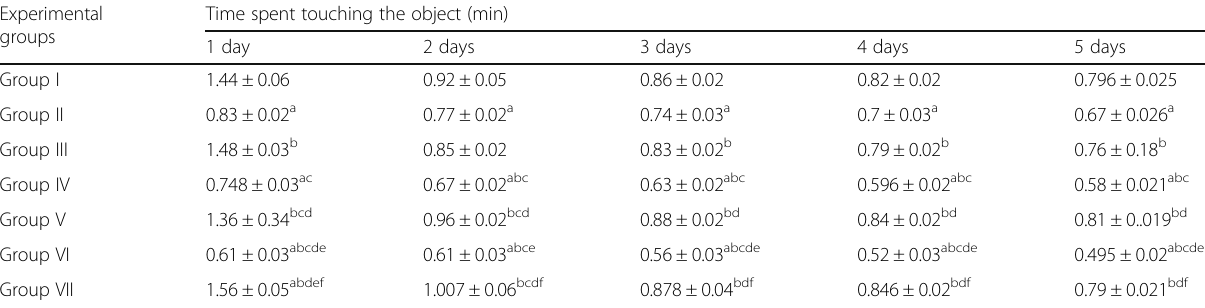
Table 3 The exploratory learning (time spent touching the object) in male offspring of groups I to VII, 70 days postnatal. Data are presented as a mean of eight rats ± SEM Experimental